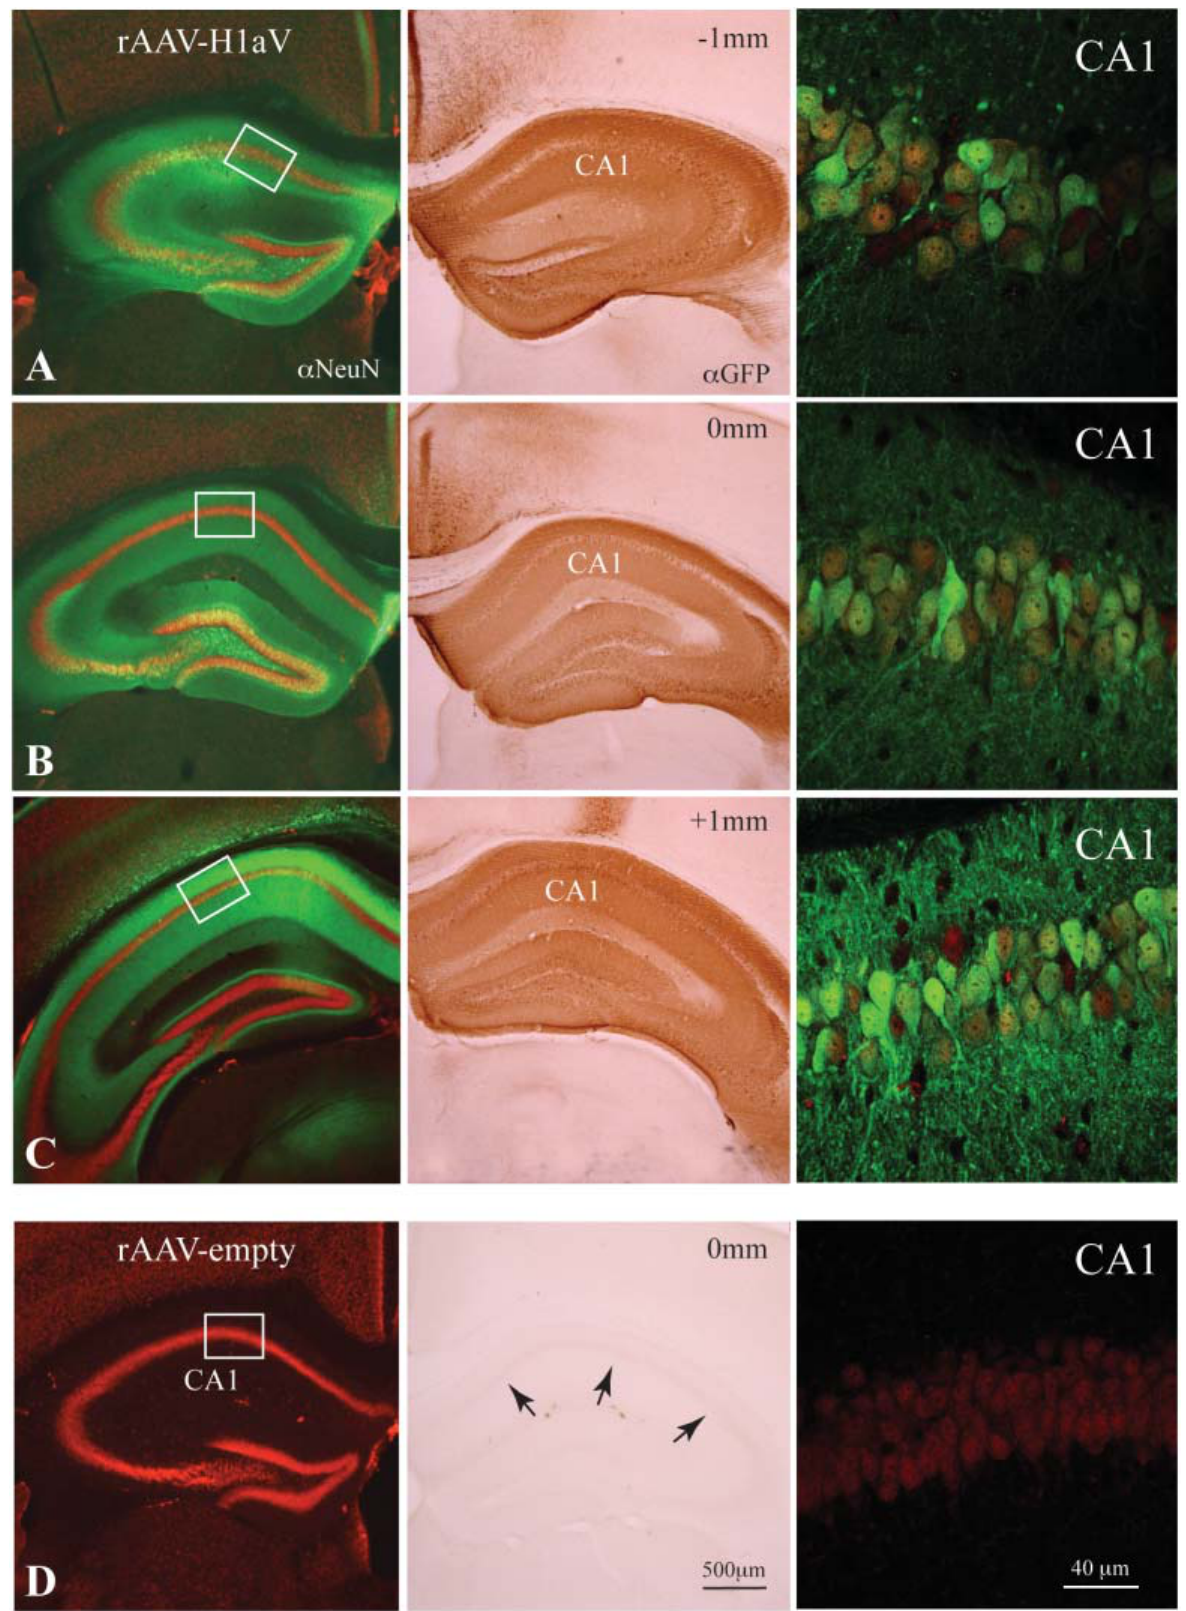
Figure 6. rAAV1/2-mediated H1aV expression in the hippocampus . ( A – D , left and middle panels) Alexa Fluor 488 or DAB enhanced anti-GFP immunohisto- chemistry for the H1aV fusion-protein on representative coronal sections approximately − 1 and +1mm from the injection site, 8 weeks after bilateral injection of rAAV1/2-H1aV/-empty. ( A – D , left panels) Z-projections of the GFP-enhanced H1aV expressing green cells/neurites (oriens layer, stratum radiatum, and molecular 106